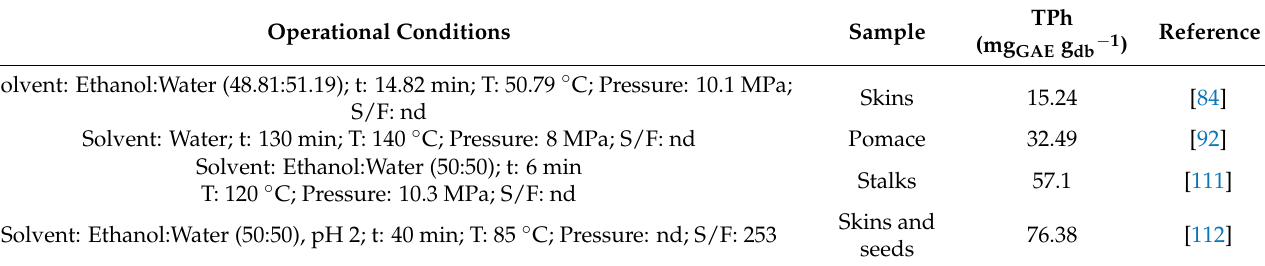
Table 9. Summary of accelerated-solvent extraction for the recovery of phenolic compounds from winery residues.